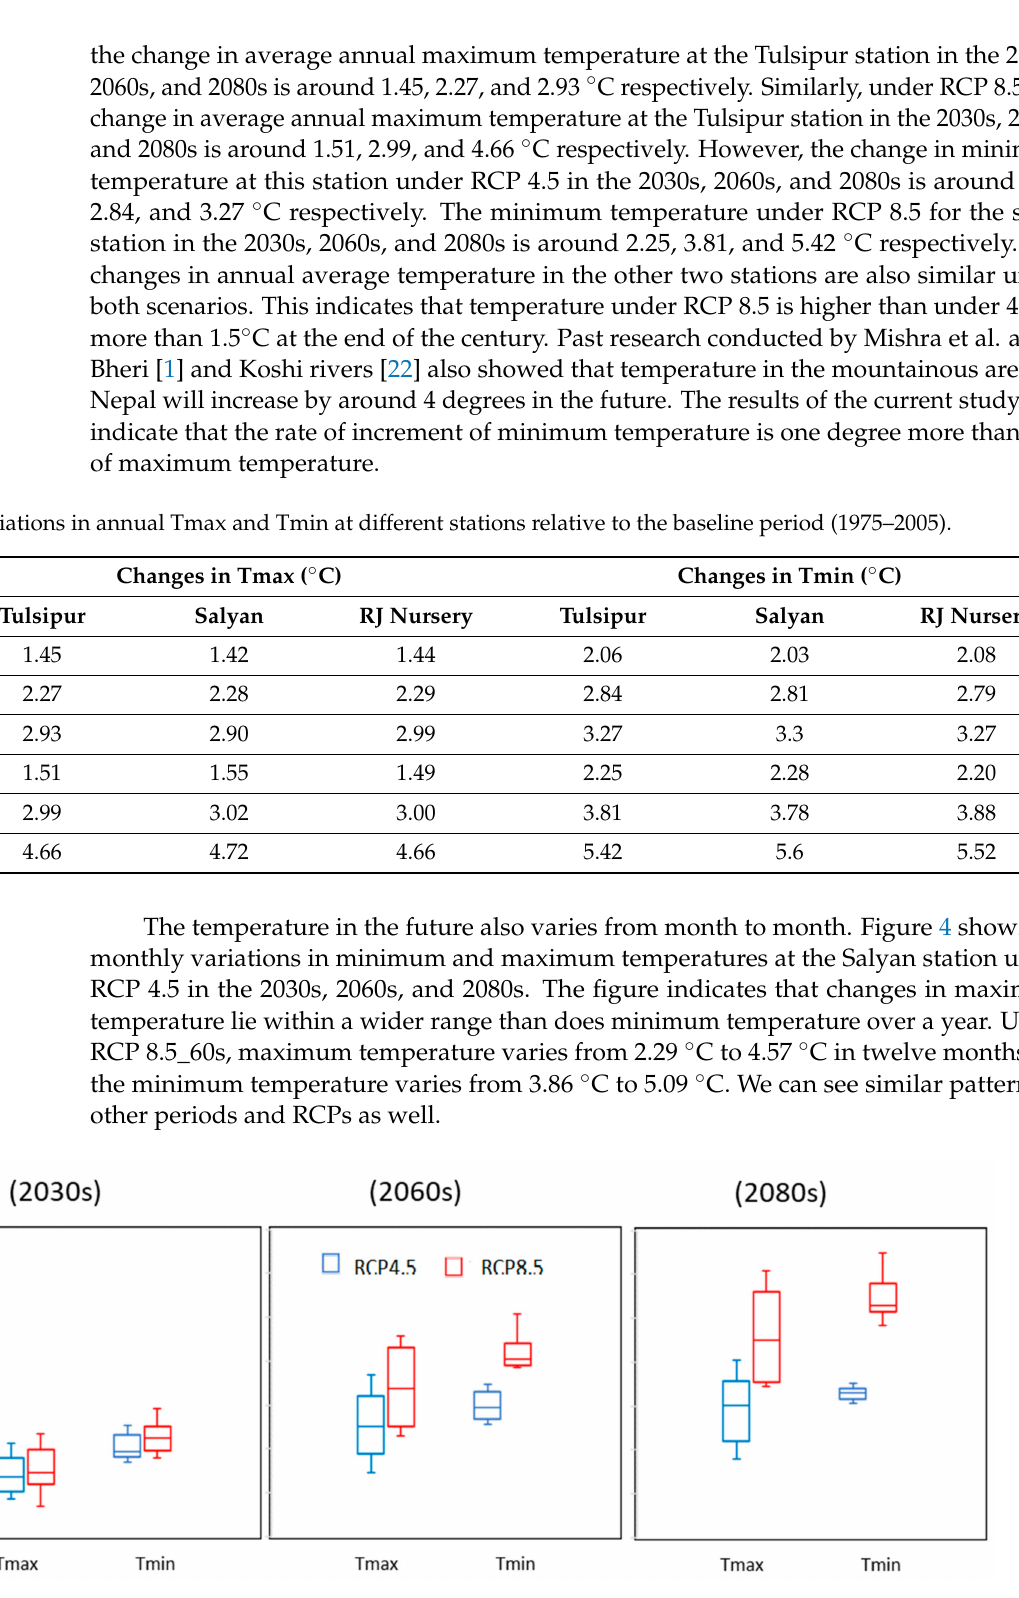
Figure 4. Relative changes in monthly mean maximum and minimum temperatures at the Salyan Scheme